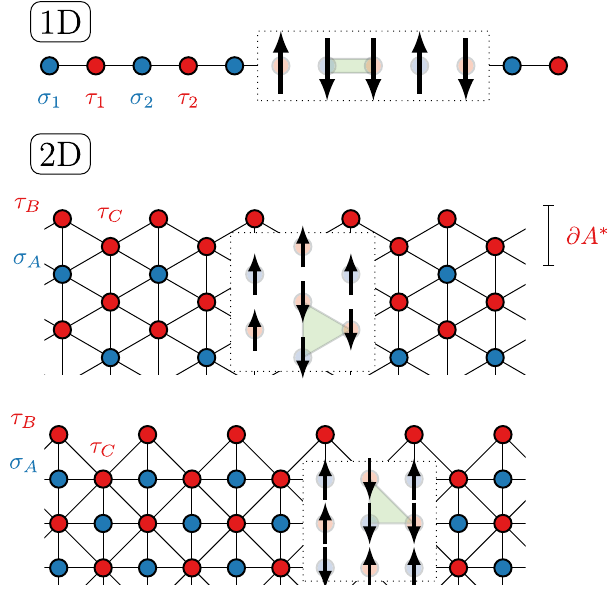
FIG. 2. Lattices used throughout this paper to construct SPT and gSPT wave functions in one (top) and two dimensions (bottom: triangular and Union Jack lattices). The control- Z twist operator used to obtain nontrivial SPTorder gives a factor of ð − 1 Þ to links with two down spins in the 1 d case and triangles with three down spins in the 2 d case, as exemplified by the green